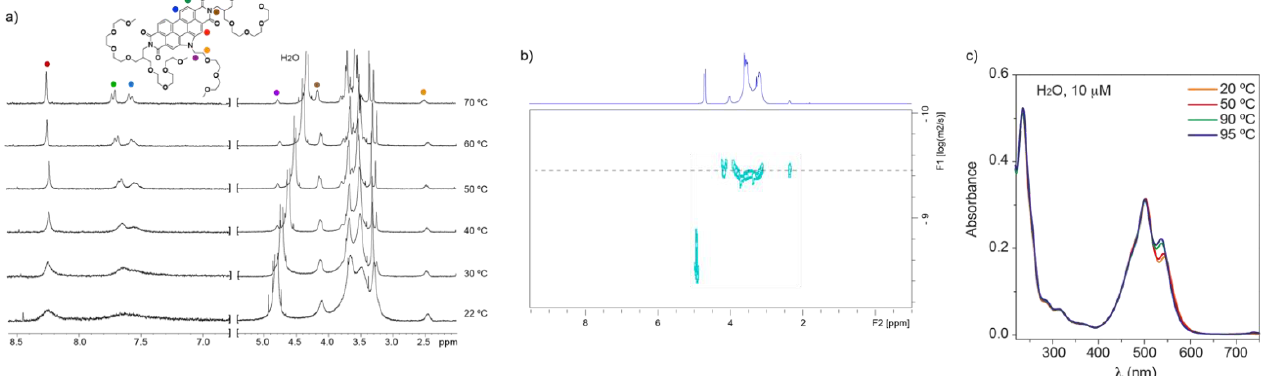
Figure 4. ( a ) VT- 1 H NMR spectra of 1 (D 2 O, 300 MHz, c T = 1 mM) showing the signals associated with the aromatic protons and to the methylene units linked to the nitrogen and oxygen atoms; ( b ) partial 1 H DOSY NMR (Δ = 160 ms, t = 3 ms) spectra of 1 (10 mM, D 2 O, 25 ◦ C, 300 MHz); ( c ) UV-Vis spectra of 1 in aqueous media at different temperatures ( c T = 10 µ M).